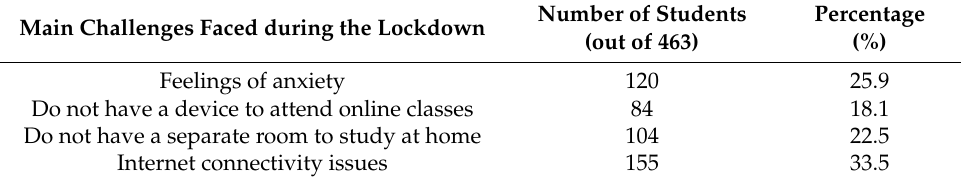
Table 8. Main challenges faced during the